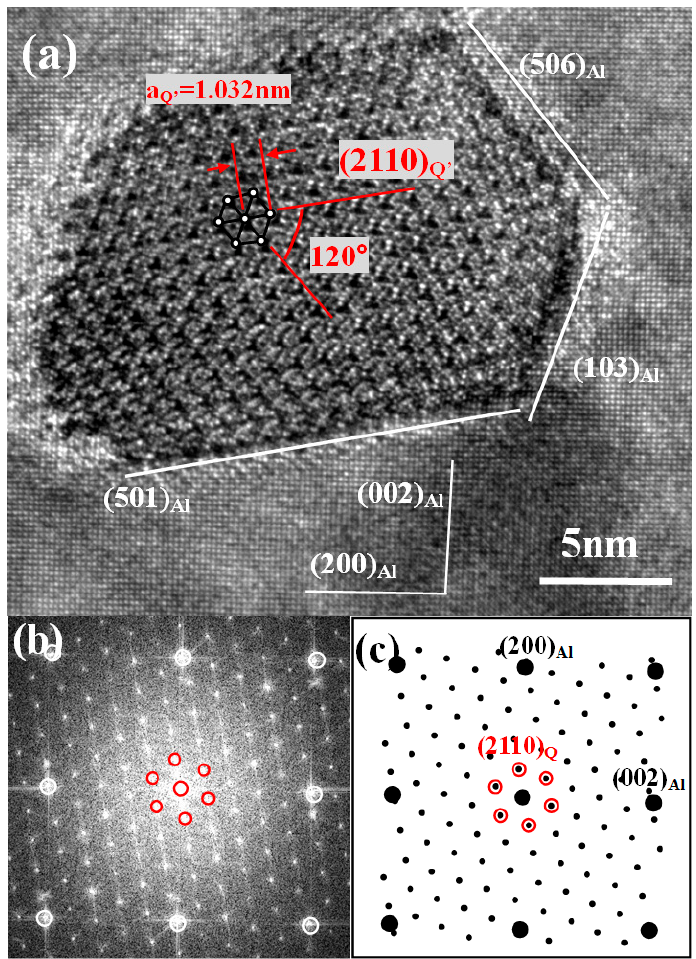
Figure 15. Granular-shaped, Q’-phase precipitate in the peak-aged Alloy 2 (165 °C/480 min) observed via the <010> Al direction: ( a ) HRTEM image; ( b ) corresponding FFT; ( c ) simulated pattern.